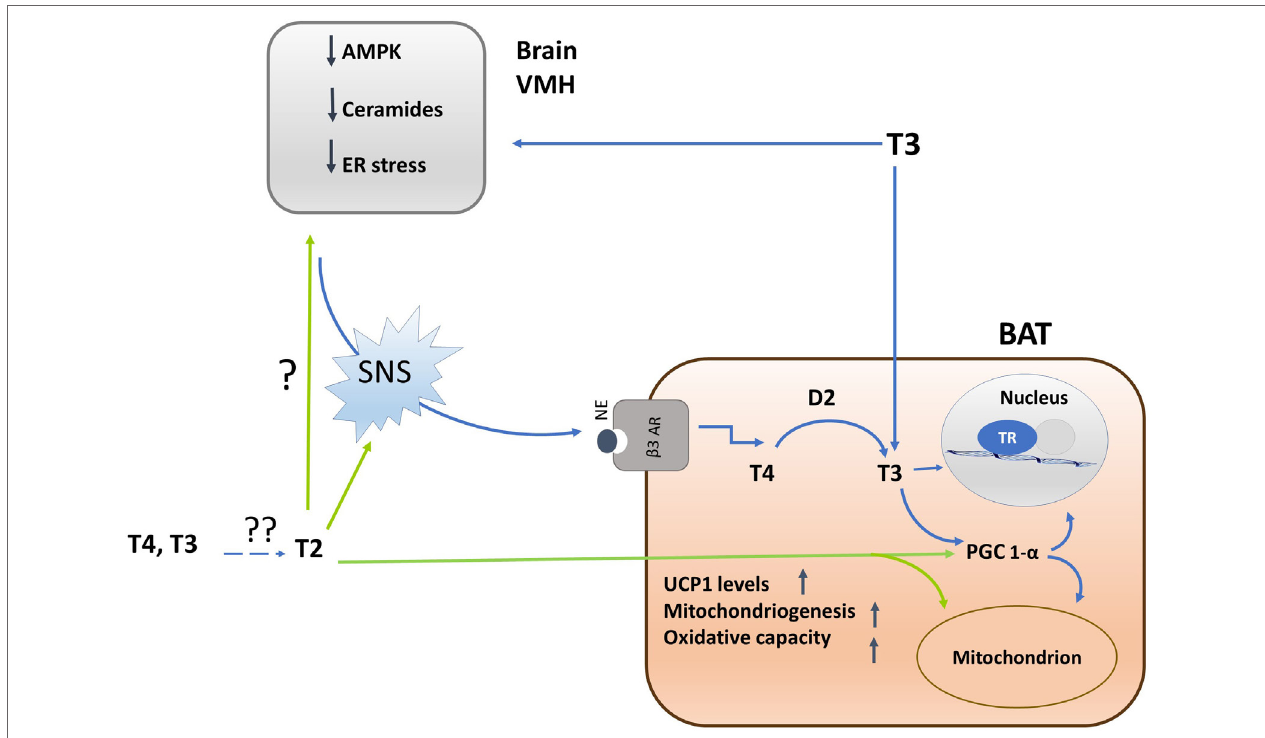
FigURe 2 | Schematic representation of the mechanisms by which iodothyronines (T3 and 3,5-T2) activates brown adipose tissue (BAT) thermogenesis and of the interrelations between central and direct effects of iodothyronines on the tissue. Single question point indicates that, despite of the fact that 3,5-T2 enhances BAT adrenergic tone, now, there are no experiments indicating whether this effect is brain-mediated or not. Double question points indicate that there are unresolved questions such as: where is 3,5-T2 coming from? Is it coming from the circulation or is it locally formed by deiodination? Is D2 involved? Experimental evidences are